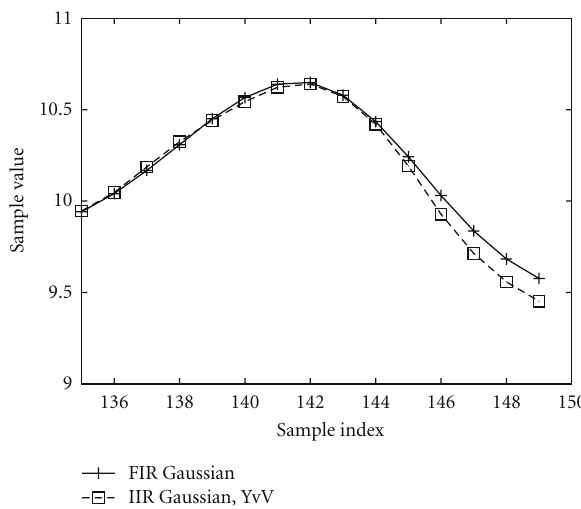
Figure 1: Example of an error after a direct Gaussian filtering on sample input data: n = 149, Sigma = 3, input extended constantly with the border value. A result of the incorrect forward-backward transition according to YvV is compared to the FIR implementation with constantlyextended border aswell. The FIR serves asa ground- truth result. The error spans 5 data